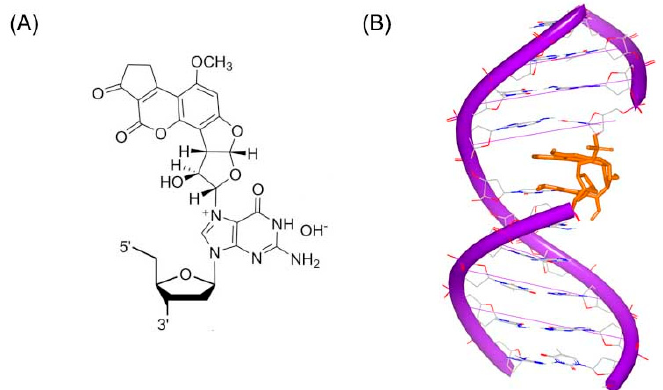
Figure 2. ( A ) Chemical structure of Aflatoxin B1 adduct; and ( B ) NMR structure of a DNA duplex complex with Aflatoxin B1 adduct (PDB code: 2KH3). The orange structure represents the small molecule; the purple structure represents the backbone of nucleic acid; the blue and red atoms in the molecule represent nitrogen and oxygen atoms, respectively.